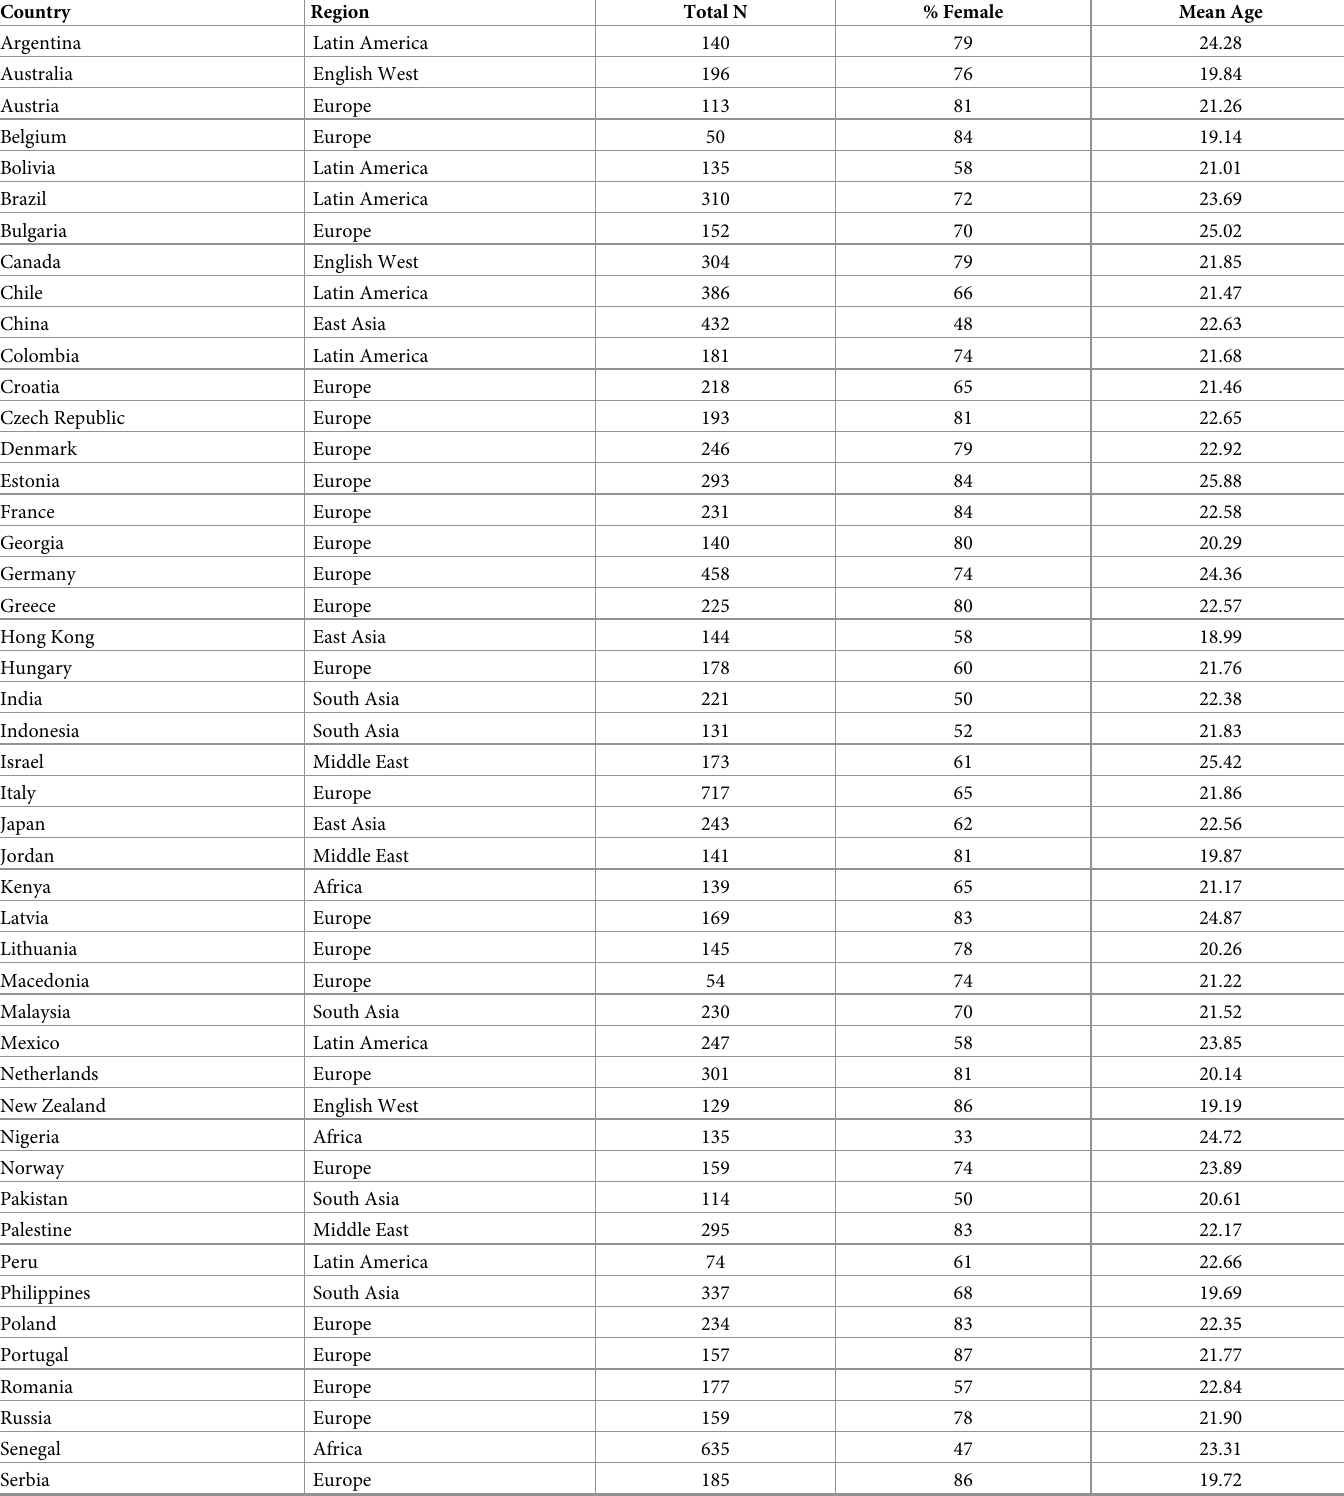
Table 1. Demographic information by